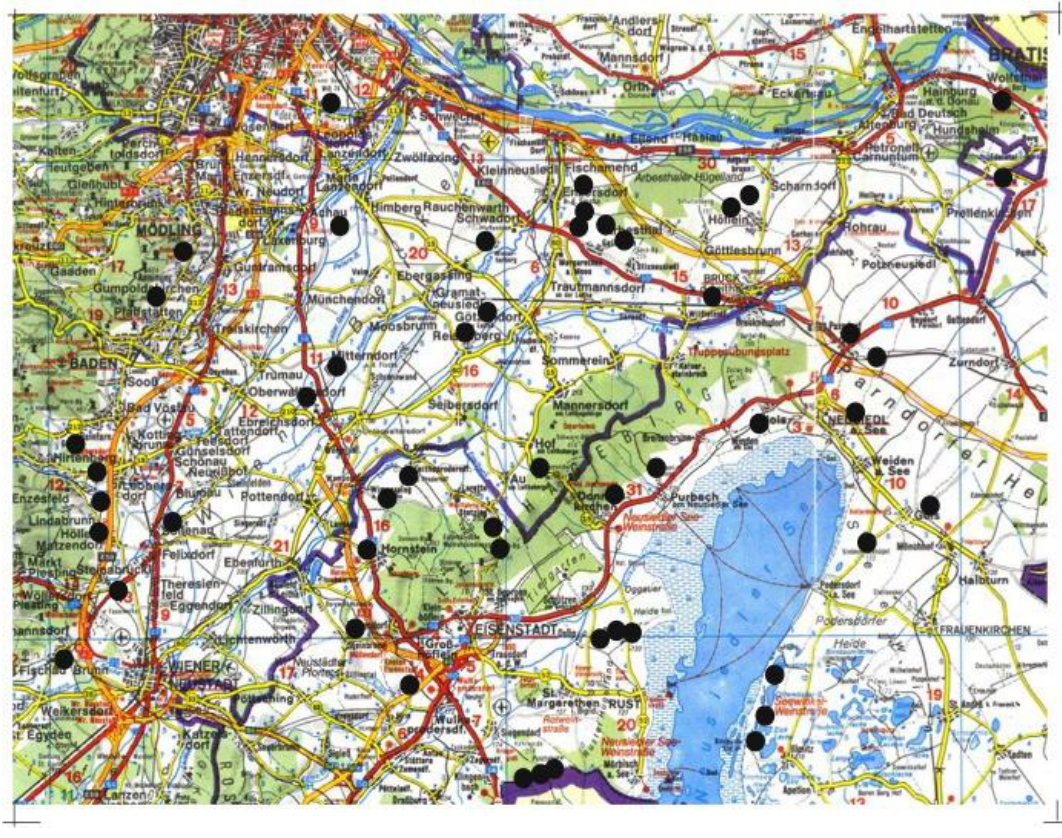
Figure 1. Map of Eastern Austria with the 50 dry grassland sites.